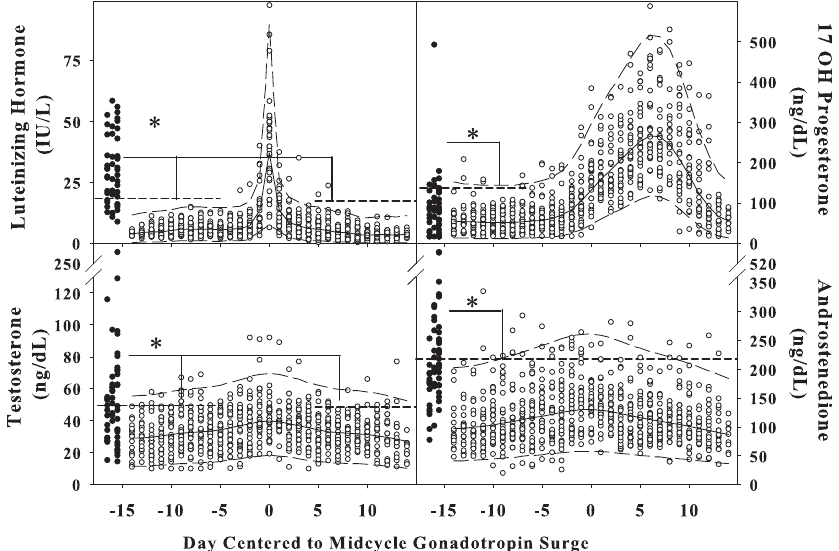
Figure 1. Hormones Across the Cycle in Controls and on a Single Day in Women with PCOS. A) LH, B) 17OH progesterone, C) testosterone and D) androstenedione levels in controls across the menstrual cycle (white circles) and women with PCOS on a day at least 10 days after the last menstrual cycle (black circles). Line plots are smoothly changed ranges of smooth model fittings using raw cycle day as the independent variable and transformed steroid as dependent variable. Solid black lines are back-transformed means and dashed lines are back-transformed mean 6 2SD. SDs are estimated using model residuals. The levels in women with PCOS are higher at all cycle phases indicated by the dotted lines and asterisks. doi:10.1371/journal.pone.0093805.g001 difference in FSH levels. As all hormone measurements were